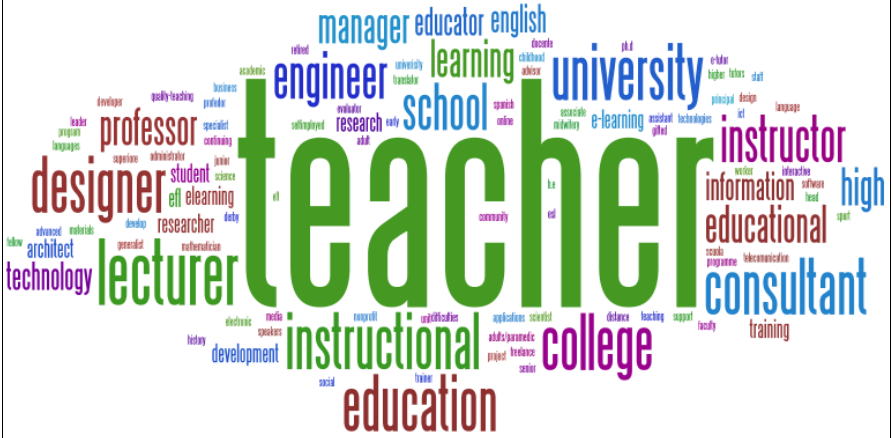
Figure 2 . The jobs tag